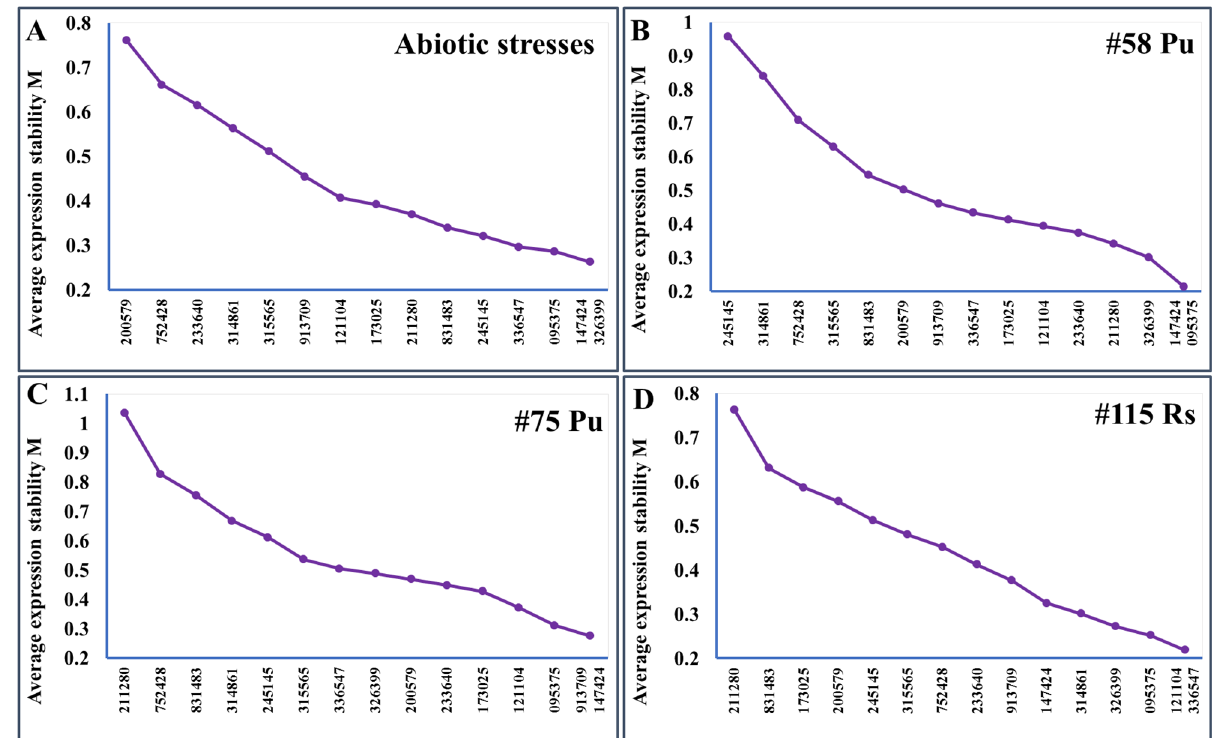
Fig 2. Gene expression stability (M) of candidate genes calculated by geNorm. (A) Abiotic stresses treated root tissues from cultivar ‘Gala’; (B) P . ultimum infected #58 roots; (C) P . ultimum infected #75 roots; (D) R . solani infected #115 roots. The least stable genesare on the left, whilethe most stable genesare on the